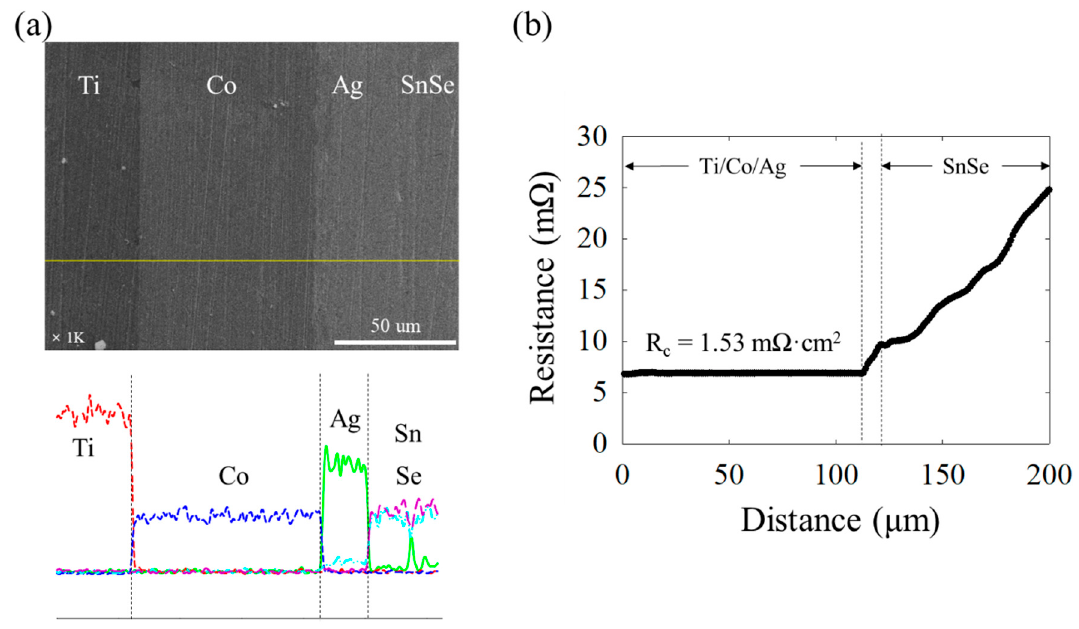
Figure 6. ( a ) SEM image and EDS line scanning of the Ag/Co/Ti multi-layer metallization; and ( b ) the graph of SCR before heat treatment.